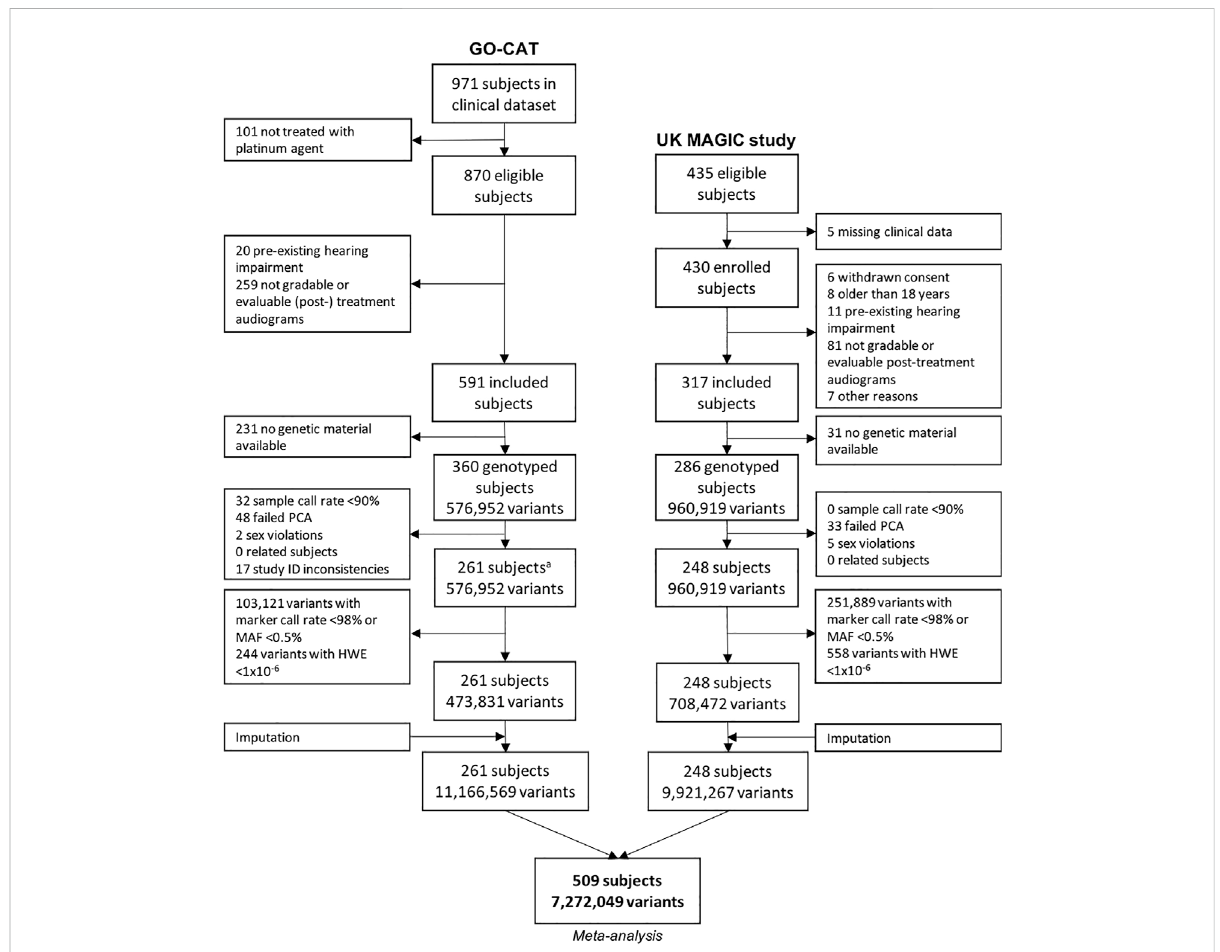
Genetic variant and sample selection fl owchart. Process of quality control of clinical and genetic data for GO-CAT cohort and United Kingdom MAGIC study cohort. A quality control of genetic data of GO-CAT cohort was performed in a larger dataset of 848 pediatric oncology subjects, of which a subset of subjects included in this study were extracted after